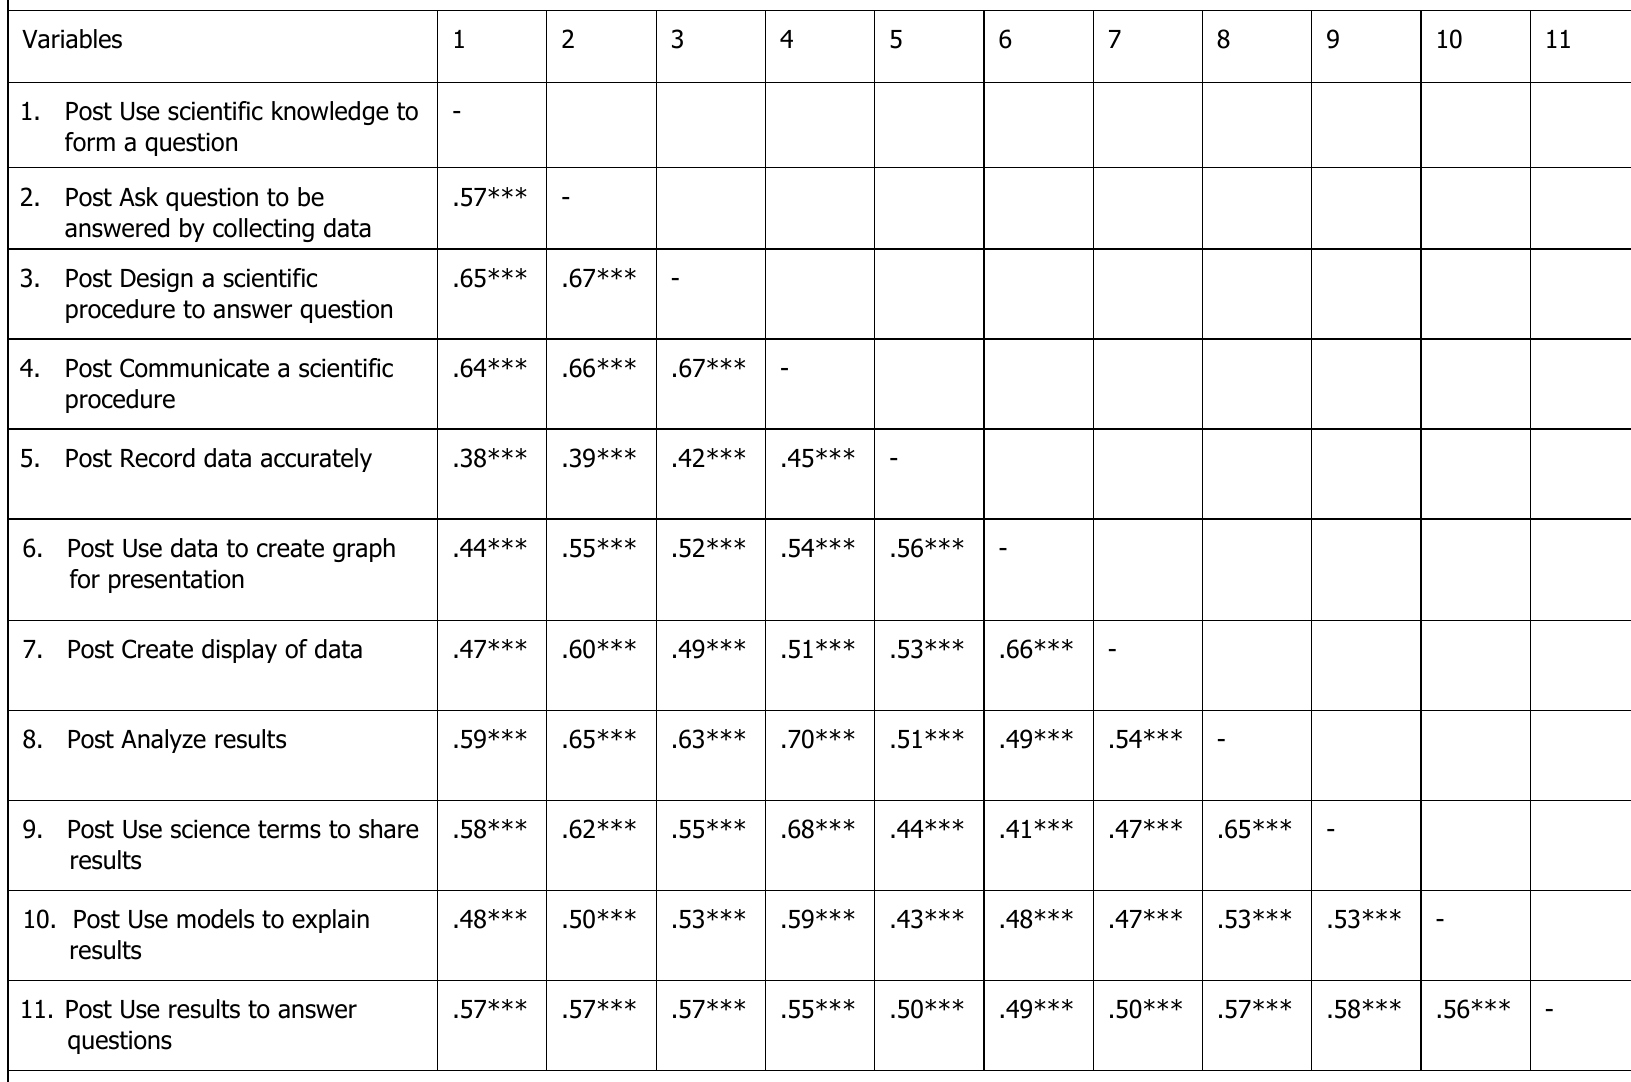
Correlations between Post-test SPSI